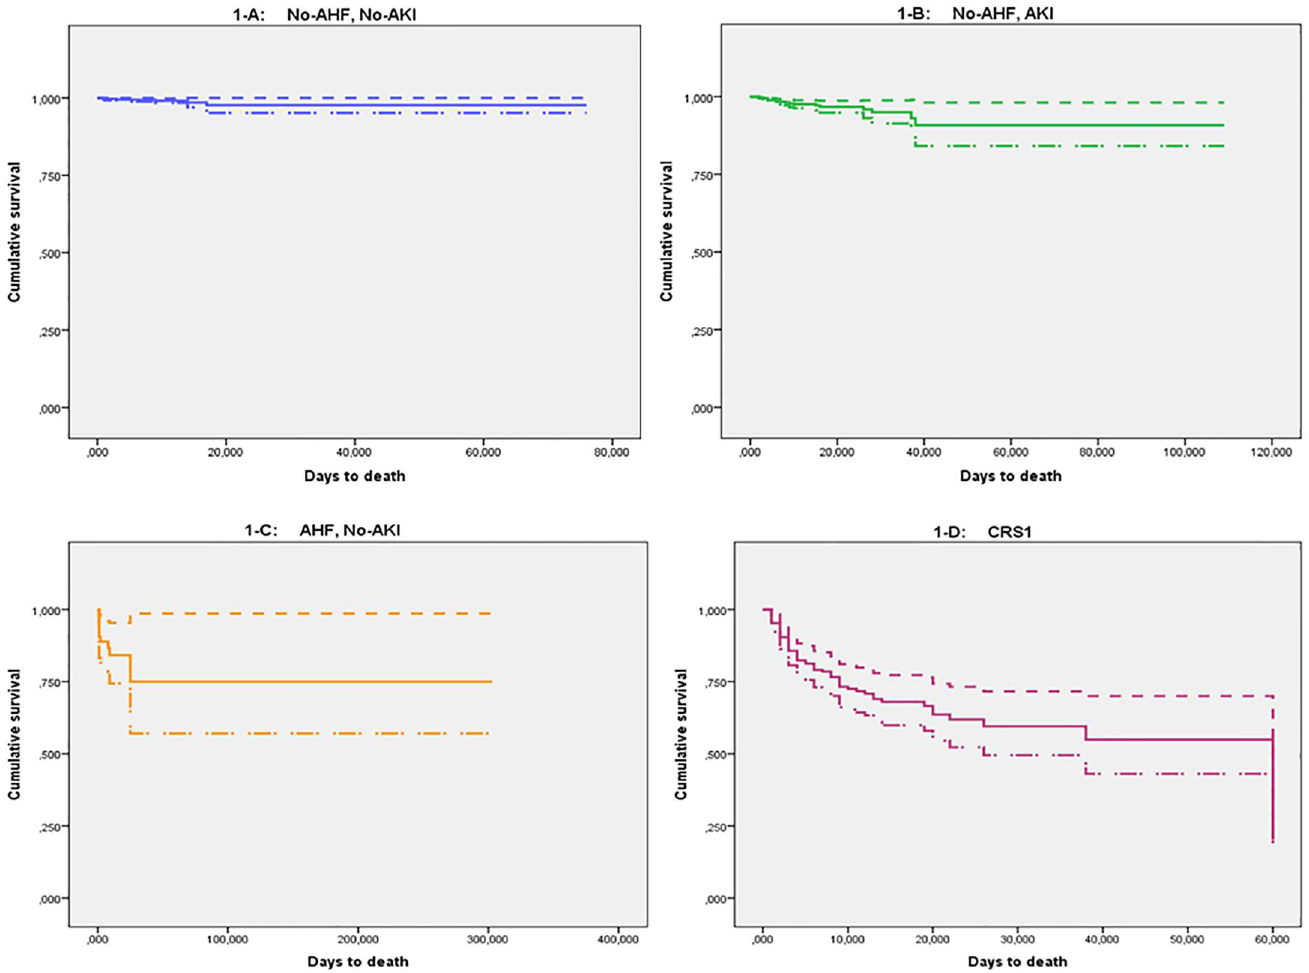
Fig 1. Survival curves, including confidence bands, for death during hospitalization for acute coronary syndrome in model A (Table 4). Fig 1A: No AHF and no AKI (referencecategory); Fig 1B: AKI but no AHF; Fig 1C: AHF but no AKI; Fig 1D =